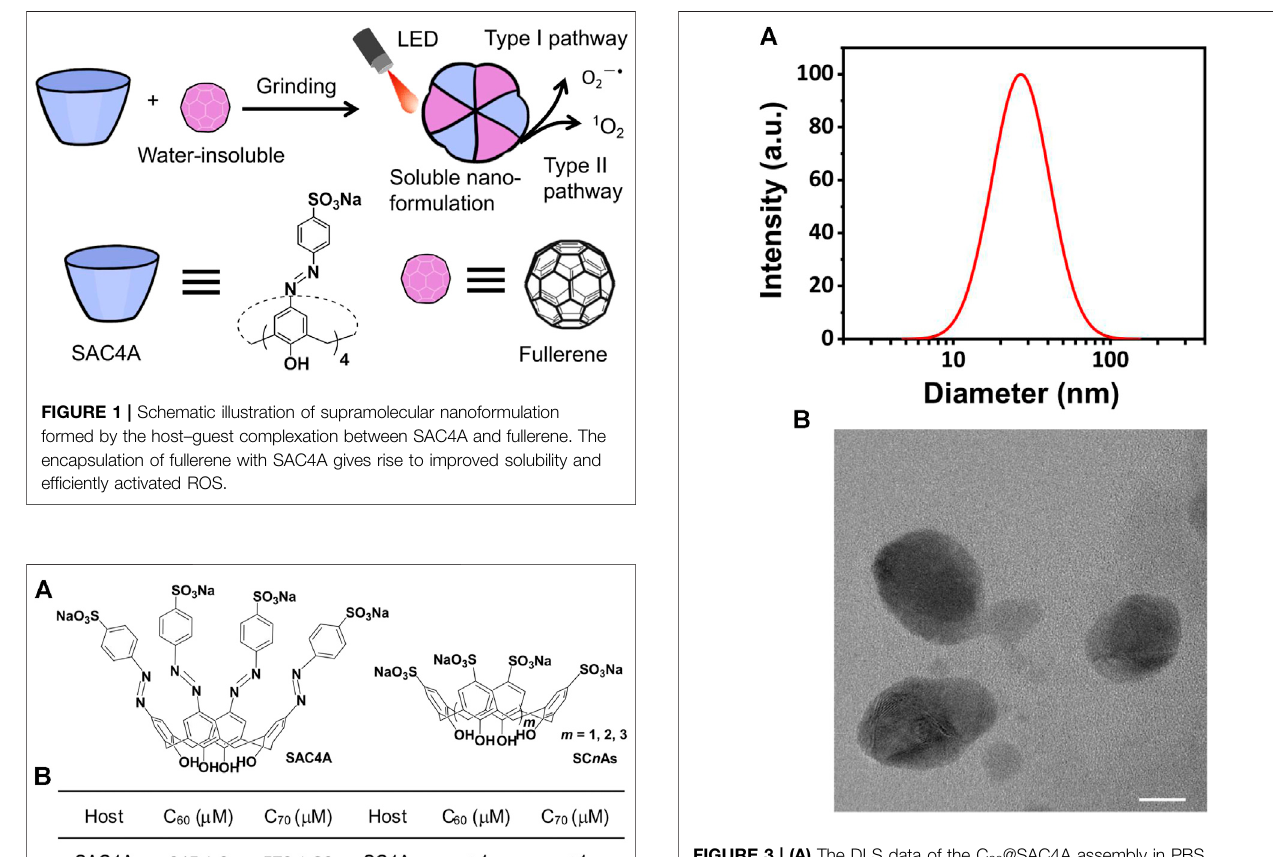
FIGURE 3 | (A) The DLS data of the C 60 @SAC4A assembly in PBS buffer (10 mM, pH (cid:2) 7.4), at 25 ° C. (B) TEM image of the C 60 @SAC4A assembly (scale bar, 10